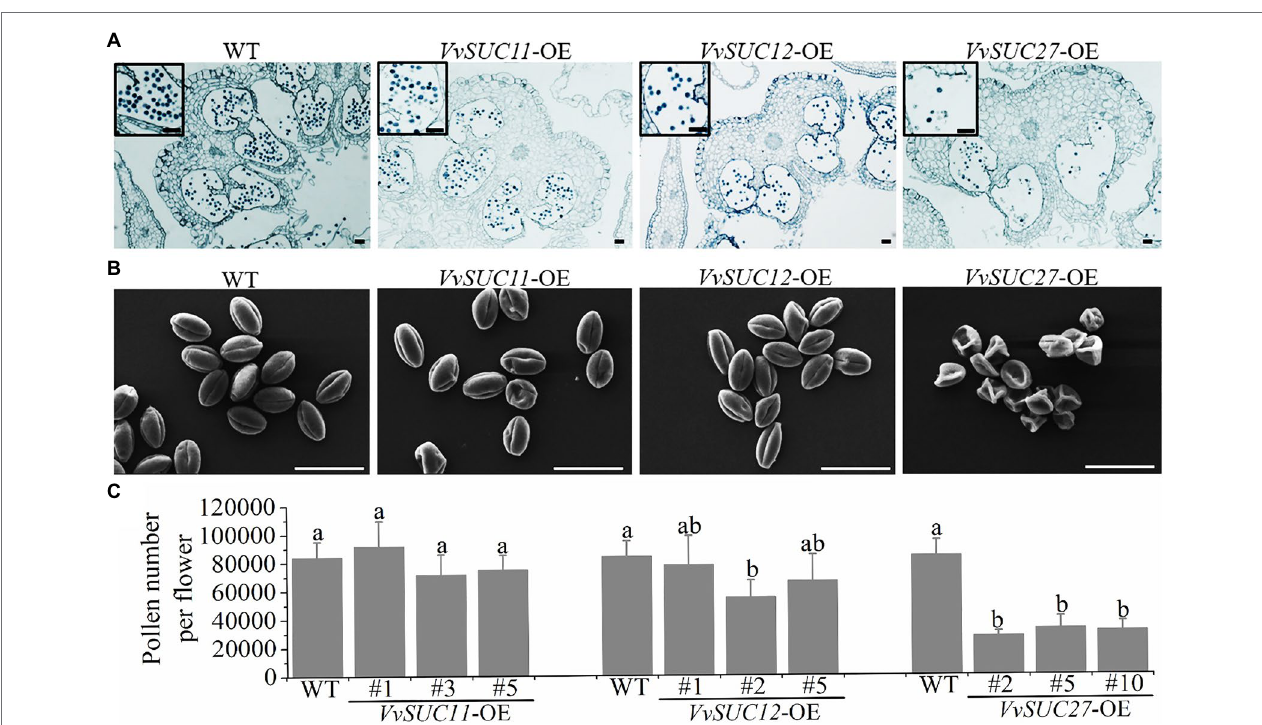
FIGURE 2 | Phenotype and number of VvSUC- OE tomato pollen grains. (A) Observation of the corollas of the WT and VvSUC -OE lines by microscopy. The pollen grains were enlarged and marked with black boxes. Scale bar, 100 μ m. (B) Observation of the pollen of the WT and VvSUC -OE lines by scanning electron microscopy (2,000×). Scale bar, 50 μ m. (C) Comparison between the WT and each VvSUC -OE line on the number of pollen grains per flower. Error bars indicate mean ± SD of six biological replicates. Different lowercase letters show statistically significant differences between the WT and each VvSUC -OE line (Tukey’s test, p <